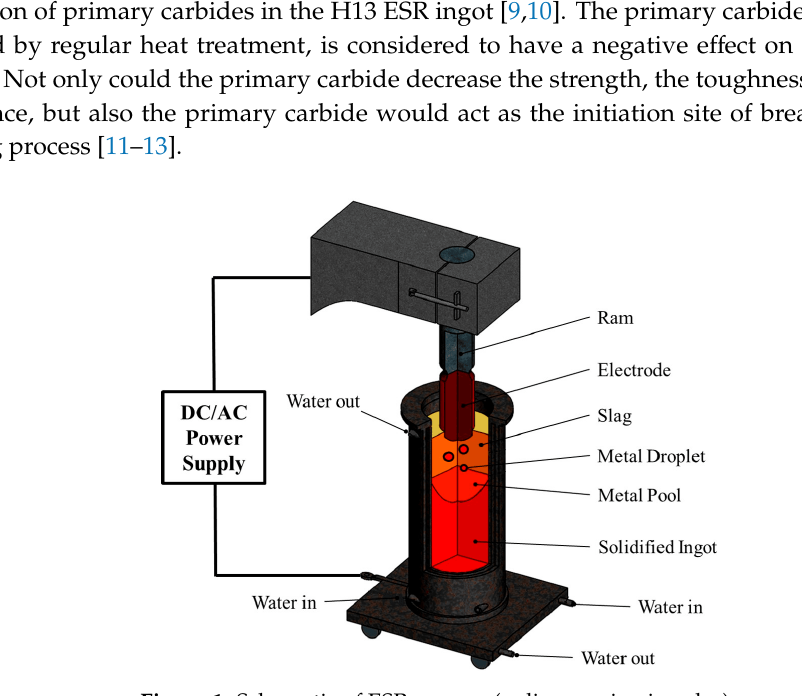
Figure 1. Schematic of ESR process (online version in color).